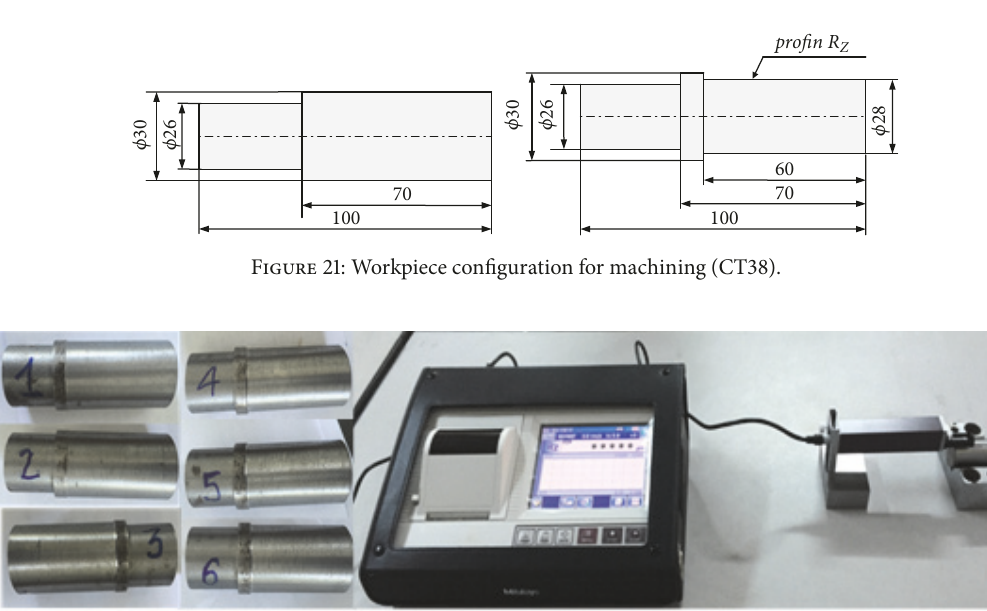
Figure 22: Details and R Z profiling process of 06 detailed samples.